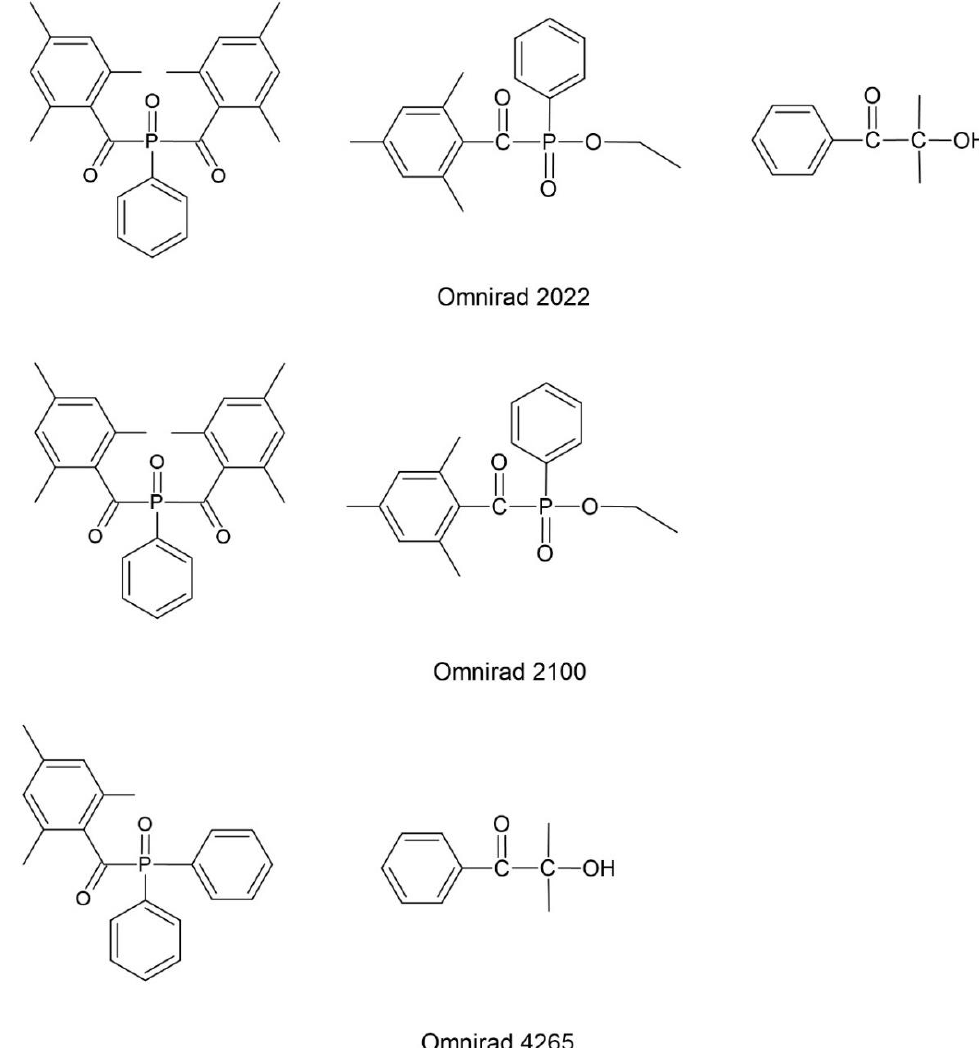
Figure 4. Structure of the free-radical photoinitiators–acylphosphine oxides.